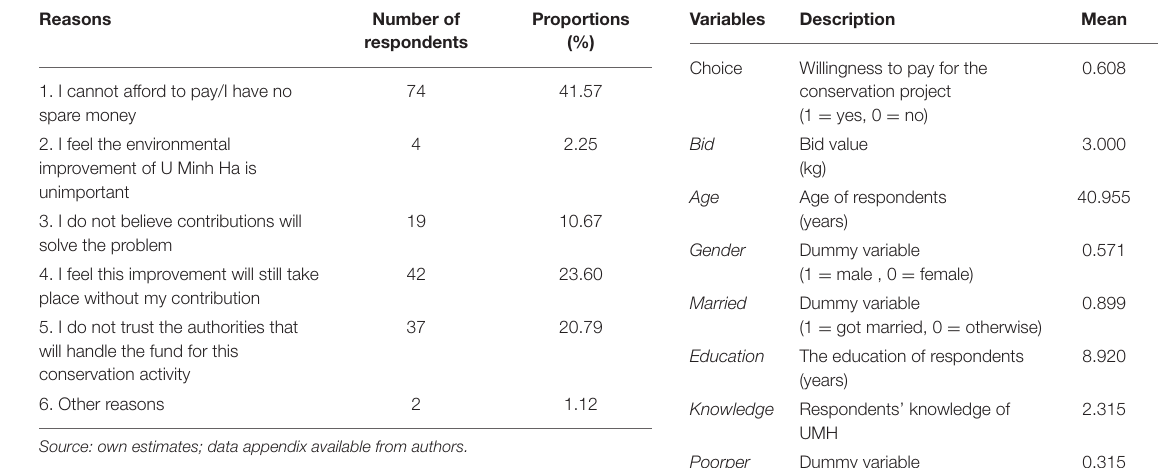
TABLE 3 | Reasons for unwillingness to pay for the forest conservation project. TABLE 4 | Descriptive statistics of variables in the logit